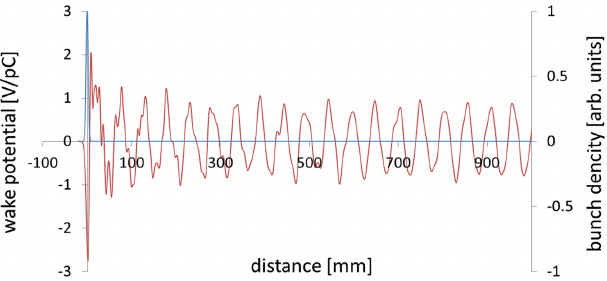
FIG. 6. Wakefield potential (red line) of a 2.5 mm bunch and a bunch shape (blue line) in the IR model